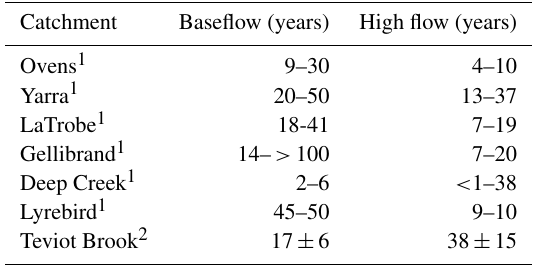
Table 1. MTTs for Australian catchments based on